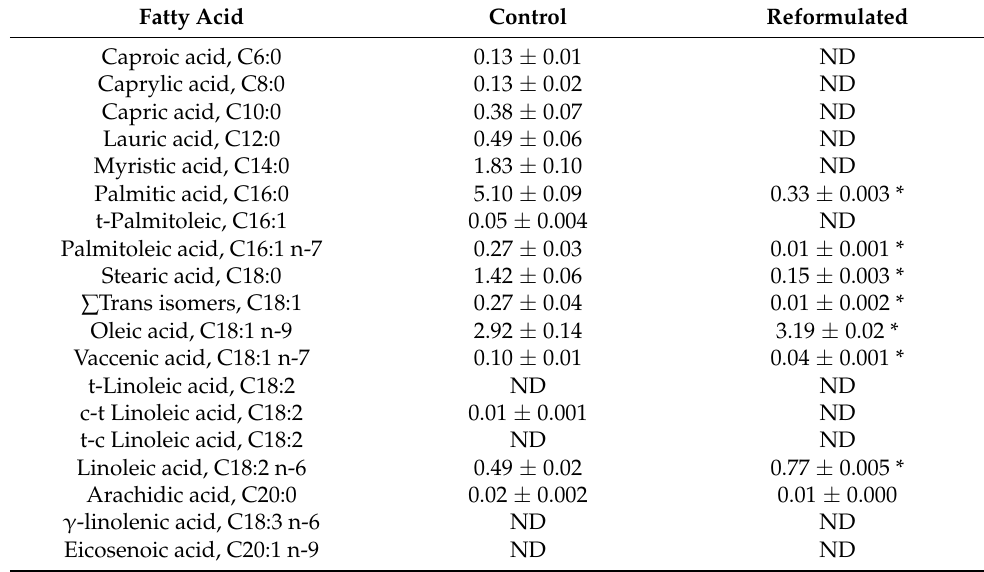
Table 3. Fatty acids profile (g/100 g of product) of control and reformulated